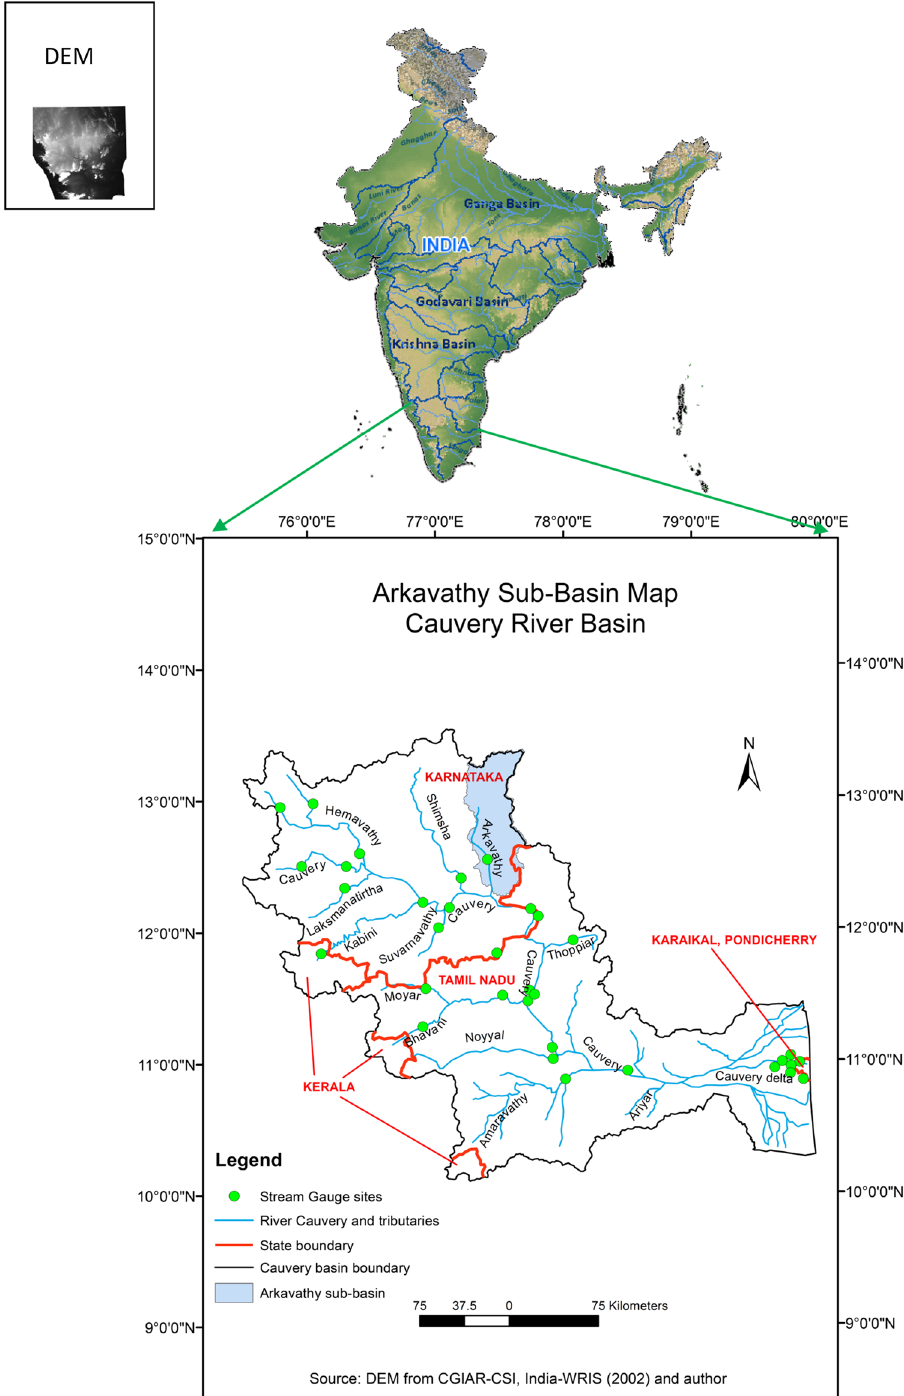
Fig. 1 Location map of Cauvery river basin and Arkavathy sub- basin along with DEM of South India (DEM resolution 90 m at